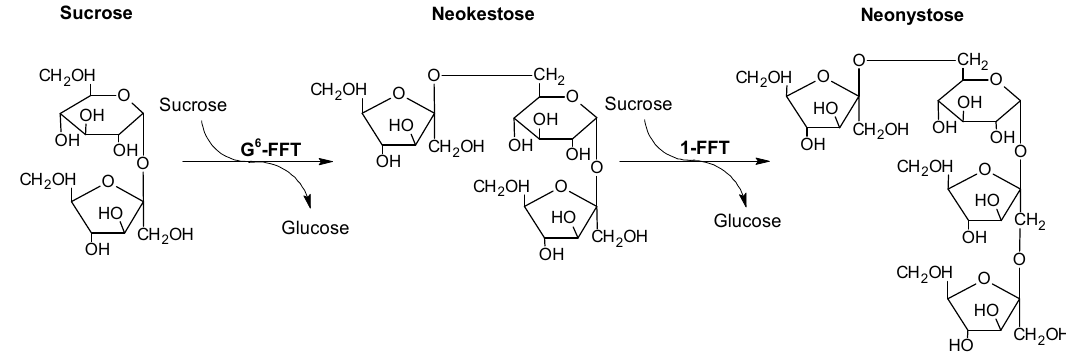
Figure 2. The neoFOS synthesis pathway starting from sucrose. G 6 -fructosyltransferase (G 6 -FFT) catalyzes the addition of β (2,6)-linked fructose to the glucose moiety to form neokestose, and 1-fructosyltransferase (1-FFT) adds a further β (2,1)-linked fructose to form neonystose.